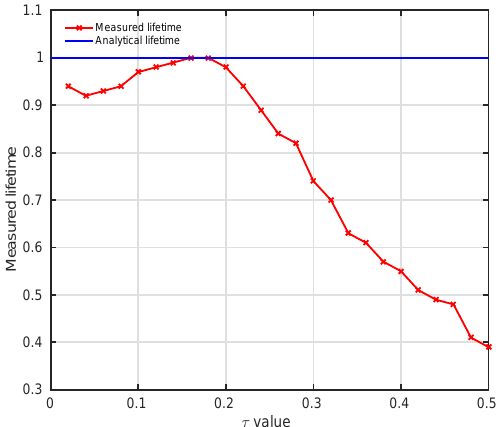
Figure 5. Time of birth of an eddy estimated with Okubo–Weiss (OW, violet); the modulus of vorticity (absVorticity, cyan); M V (red); and the eddy tracking tool box (ETTB, blue) by Nencioli et al. (2010) for vortex strength w 50, 100 and 200. The black diagonal depicts the analytical time of birth of an eddy.